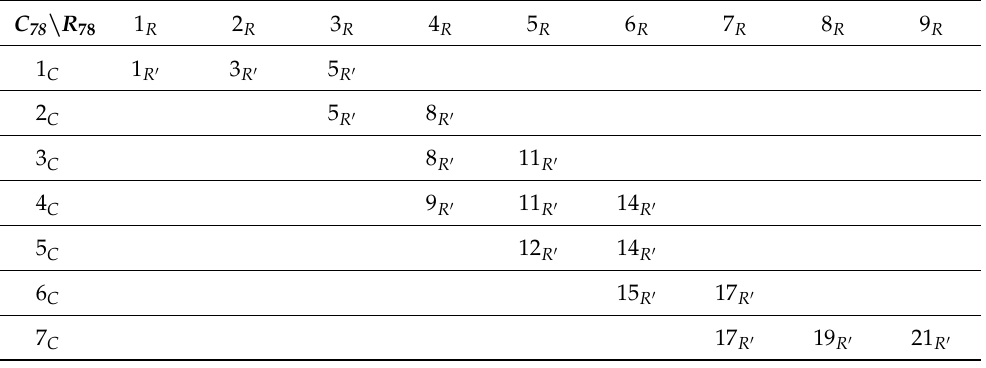
Table 9. Fuzzy rules designed for weak failure correlation Machine pair 7–8.